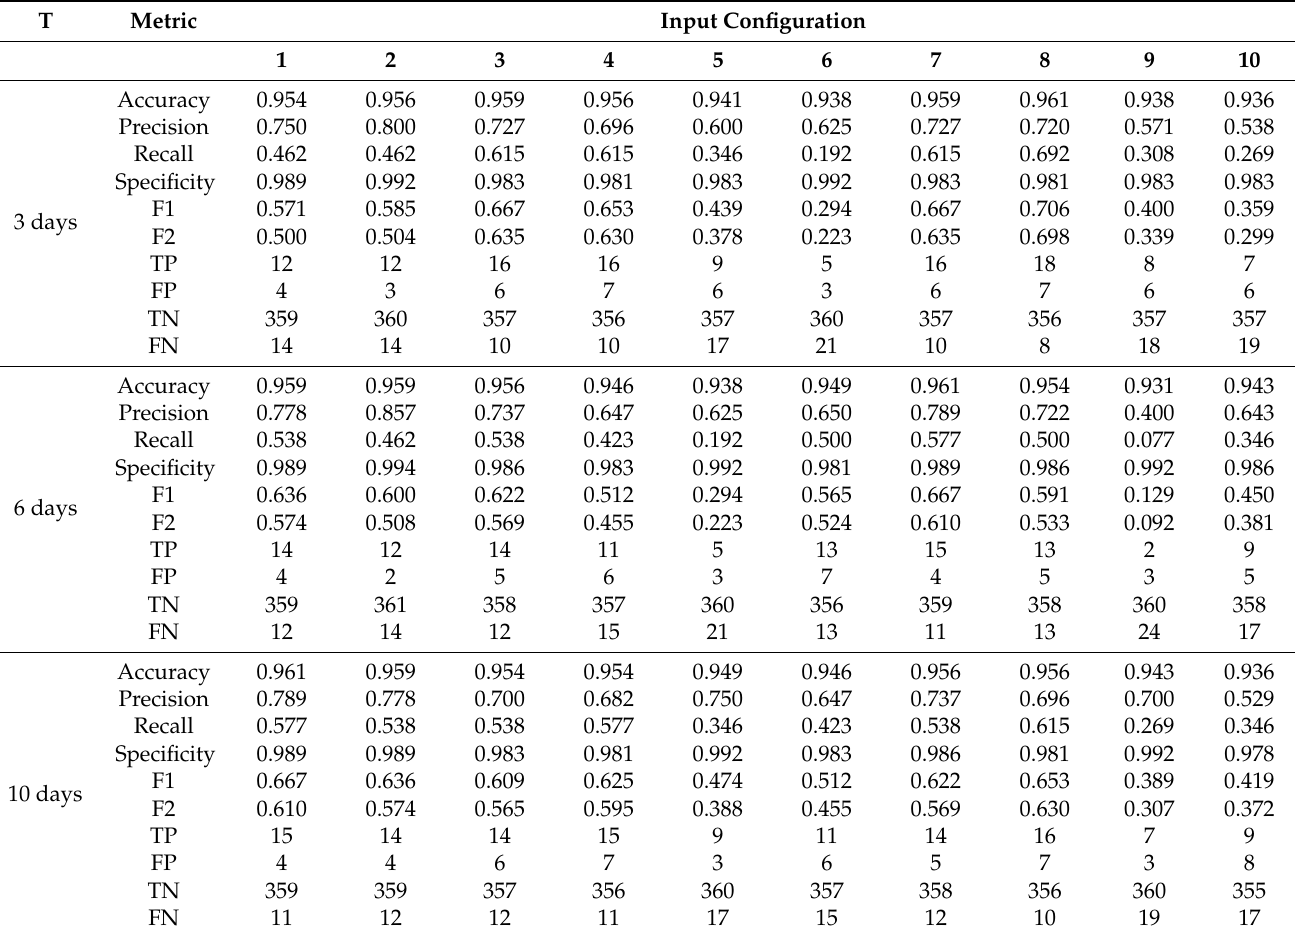
Table 4. RF model classification performance metrics with the imbalanced dataset.